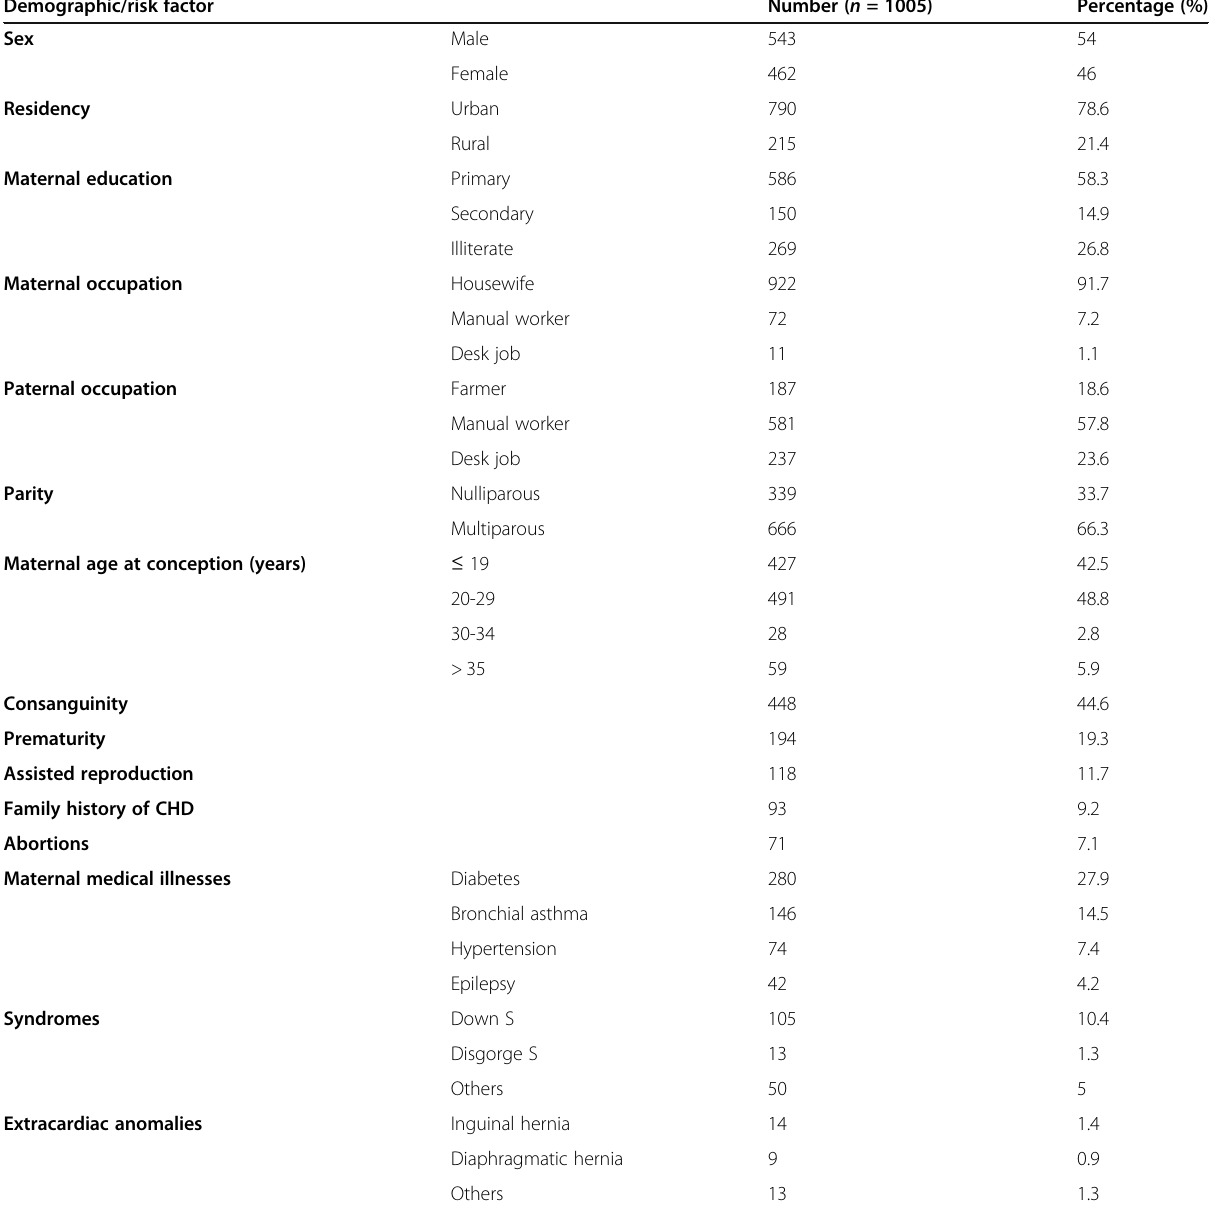
Table 2 Distribution of demographic data and risk factors Demographic/risk